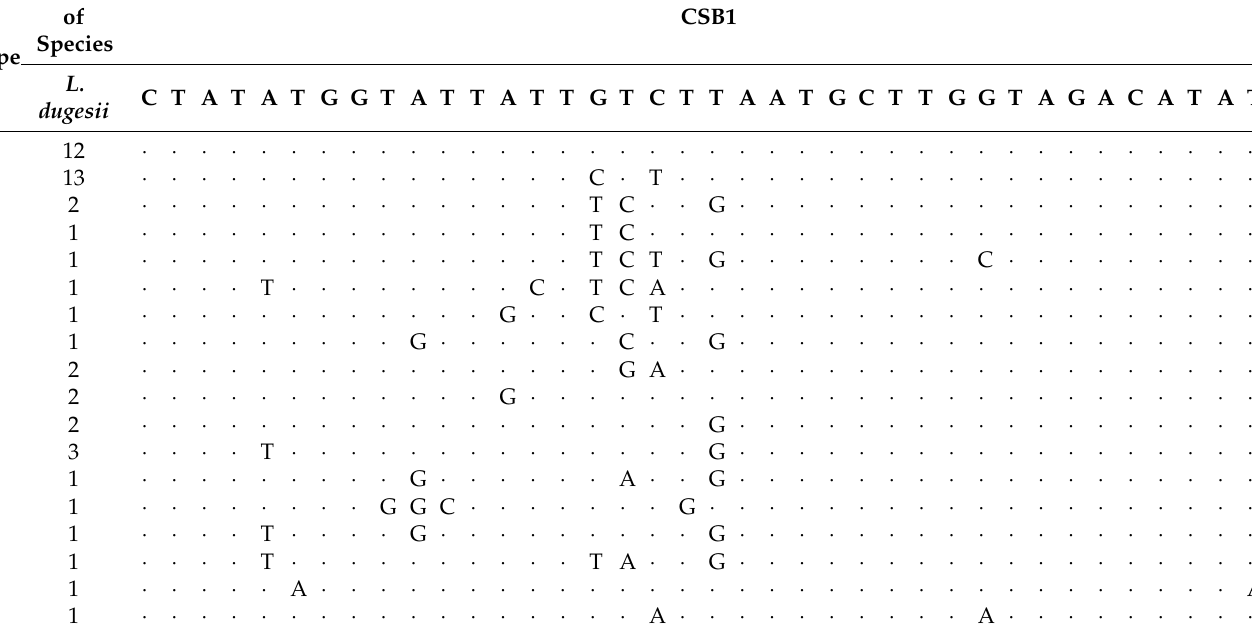
Table 4. Type of conserved structure element of CSB1 in